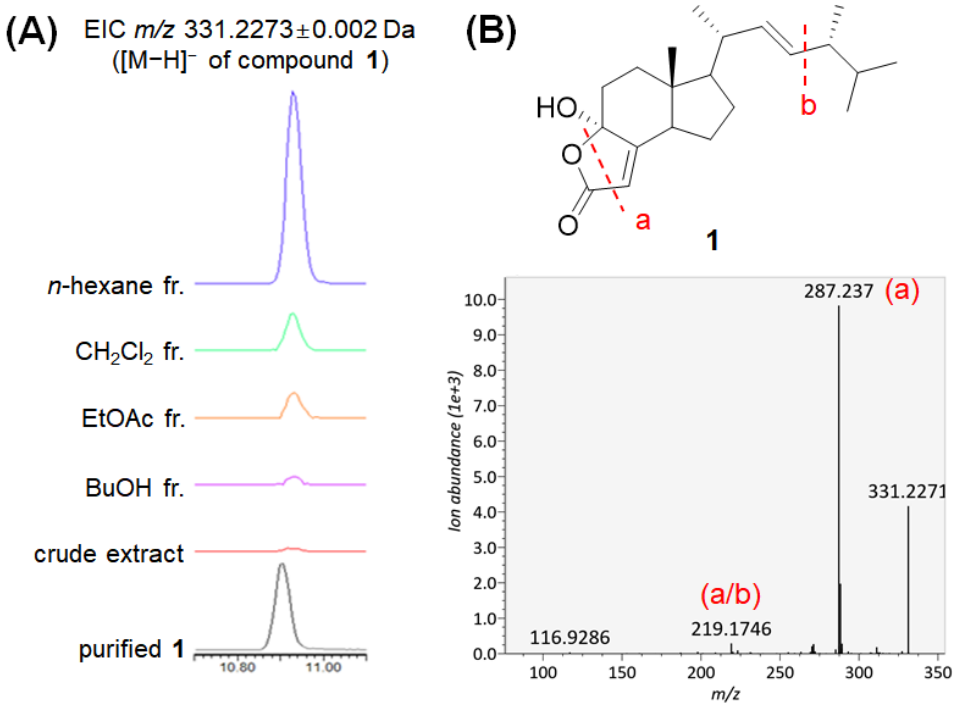
Figure 4. ( A ) Detection of compound 1 in the crude extract and fractions of D. confragosa . EICs of the extract and fractions are in the same scale; the peak height represents the relative abundance of 1 . ions are shown. Table 3. Fungal species found to contain compound 1 , according to the MASST analysis.